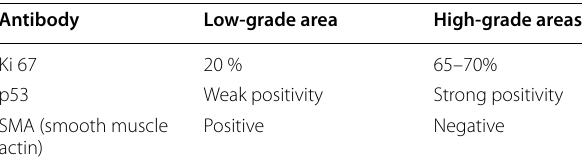
Table 1 Immunohistochemistry study of different areas of the